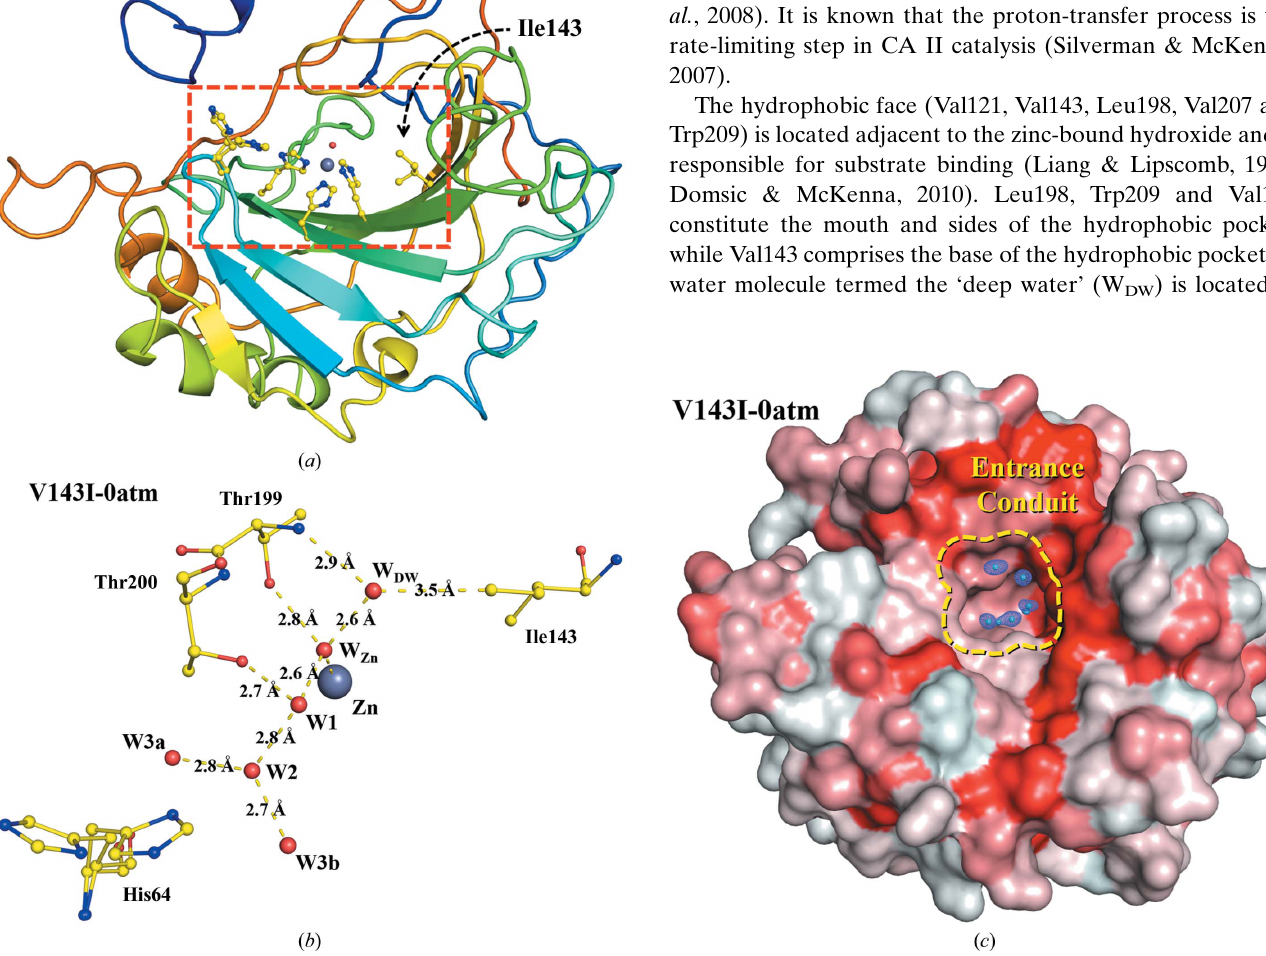
Figure 1 Structure of V143I CA II. ( a ) Overall structure of V143I-0atm: V143I CA II with no CO 2 pressurization. The active site (red box) is located at a depth of 15 A˚ from the surface. Note that Ile143 is located at the hydrophobic pocket in the active site. ( b ) Ordered water network in the hydrophilic region serving as a proton-transfer pathway. ( c ) Surface rendition of V143I-0atm. The entrance conduit (diameter of 7–10 A˚ , guided with a yellow dotted line) connects the active site to the bulk solvent outside, forming the replenishment pathway. The electron density of the entrance-conduit waters is contoured at 1.5 (cid:2) . Hydrophobic amino acids are shaded in red, while hydrophilic amino acids are coloured